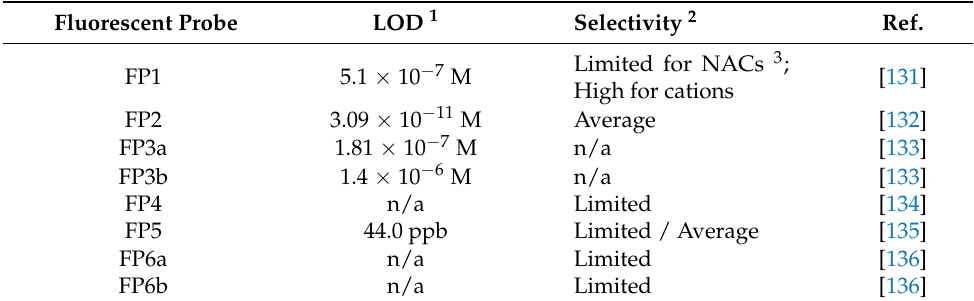
Table 6. Summary of polymer and organic fluorescent probes used for the detection of picric acid. Numeric designations refer to compounds presented in Figure 6.